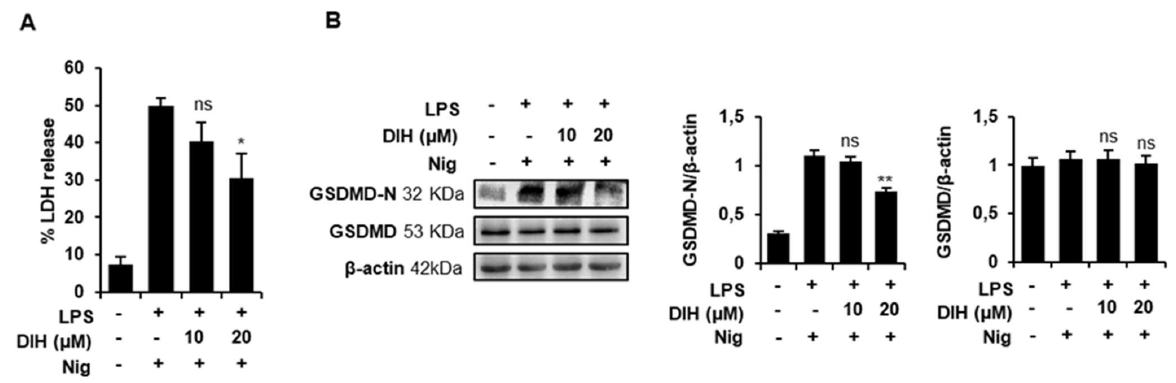
Figure 4. DIH attenuates NLRP3-dependent pyroptotic cell death. ( A ) LDH release was measured using a CytoTox ® kit in the supernatants of LPS-primed J774A.1 macrophages treated with DIH (10, 20 μM) and stimulated with Nig (20 μM, 1 h). Results are expressed as means ± SD (n = 3). ( B ) Immunoblot analysis of GSDMD-N and GSDMD expression in cell lysates. β-actin was immunoblotted as a loading control. Densitometry analysis shows the mean ± SD of the western blot experiments. ns = not significant, * p < 0.05 and ** p < 0.01 vs. LPS + Nig treatment.